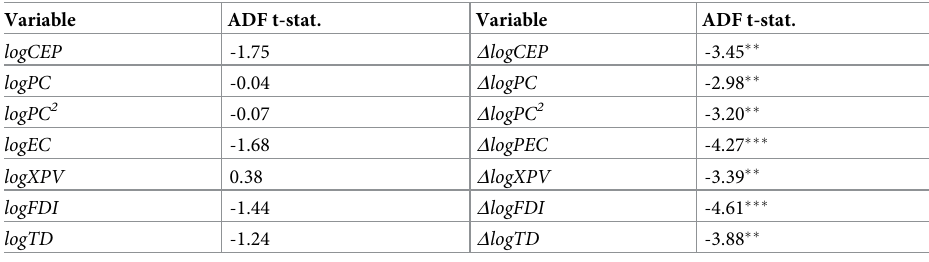
��� and �� indicate significance at the 1% and 5% levels,